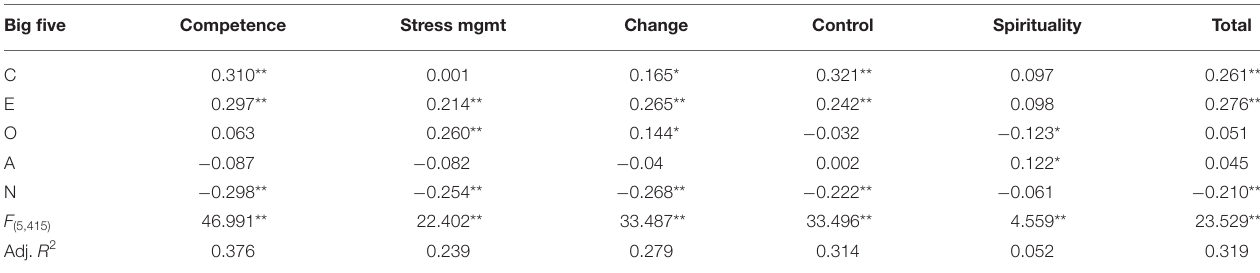
TABLE 2 | Multiple regression between the BF factors and Resilience ( n = 405).